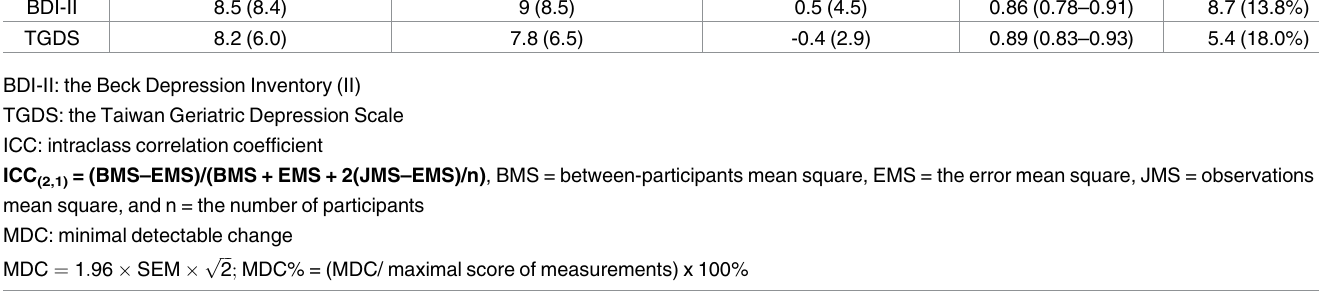
Table 2. The test-retest reliability indices of the BDI-II and the TGDS (n = 70).